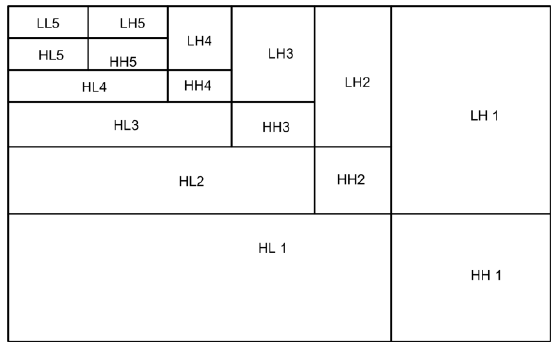
Figure 2. Wavelet filter